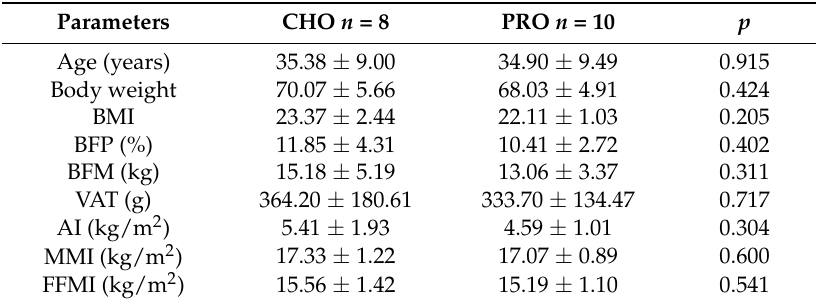
Table 3. Baseline characteristics of